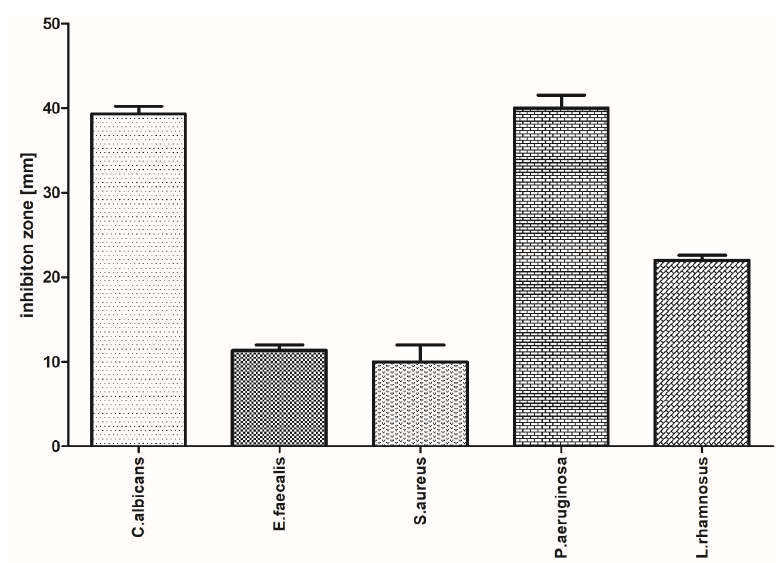
Figure 7. Inhibition zones (mm) of microbial growth generated by PVA / HPMC_B film with incorporated PVP-I (mean ± SD).